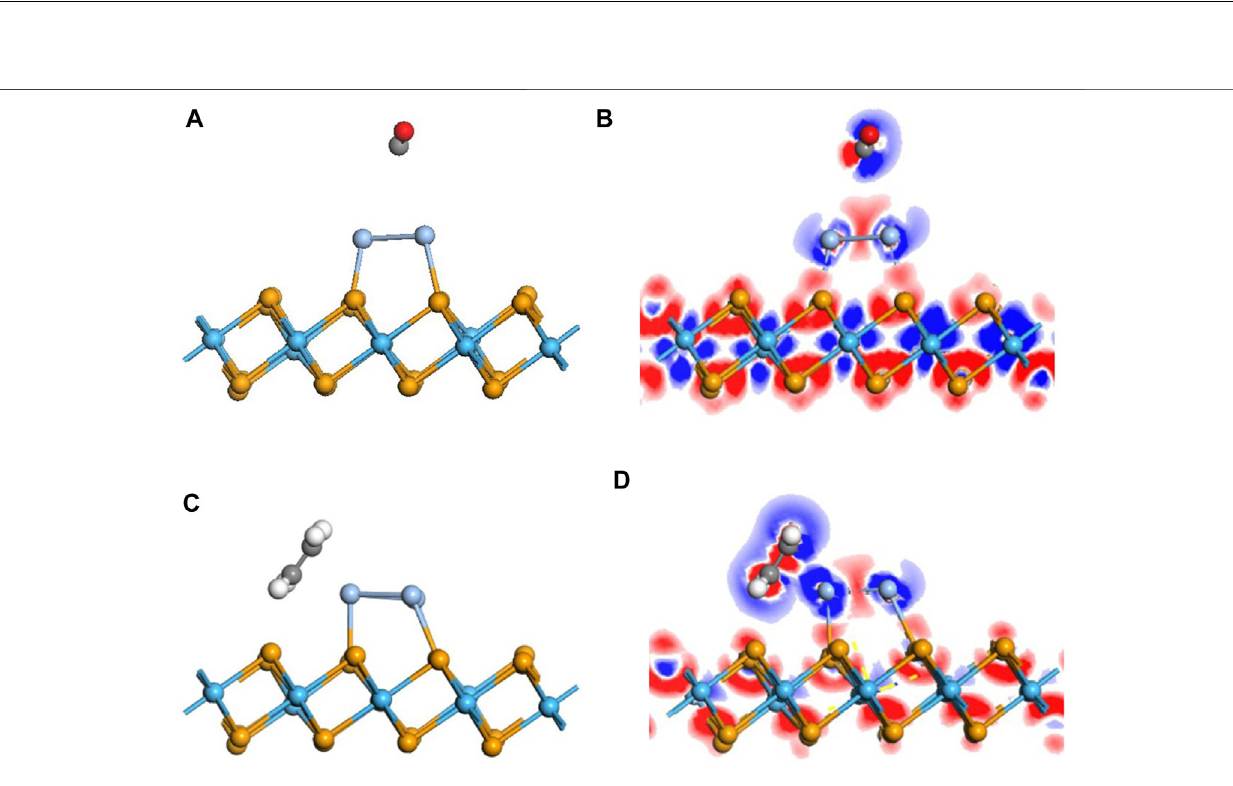
Frontiers in Chemistry |